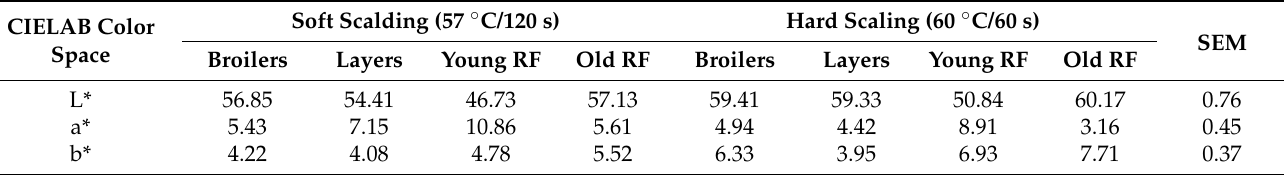
Table 2. Effects of soft and hard scalding on breast meat color of different breeds of